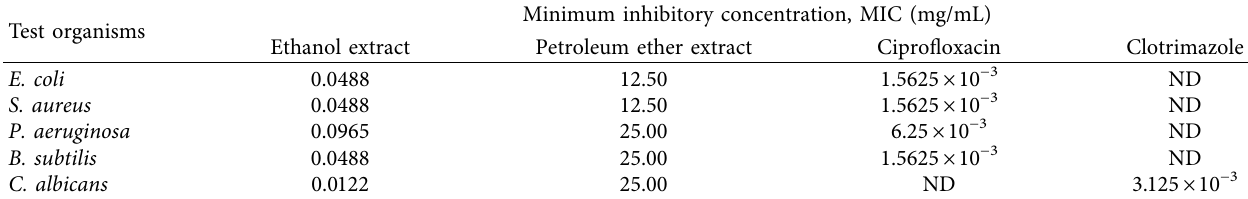
Table 4: MICs values of C. nioroense extracts and reference drugs concentrations against test organisms.